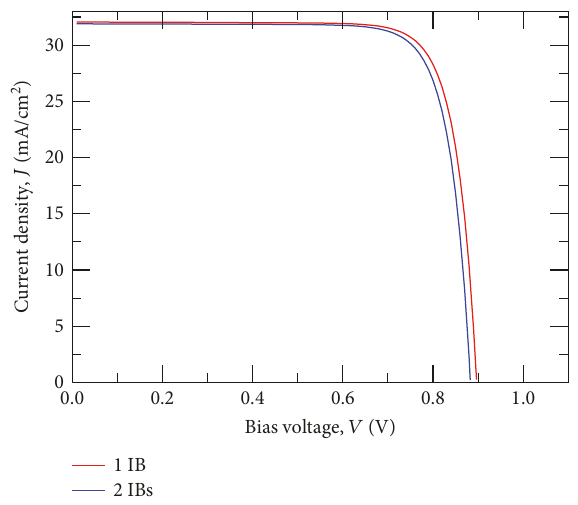
Figure 9: J – V characteristic curves for 1 IB and 2 IBs. Table 3: Summarized results of J intermediate